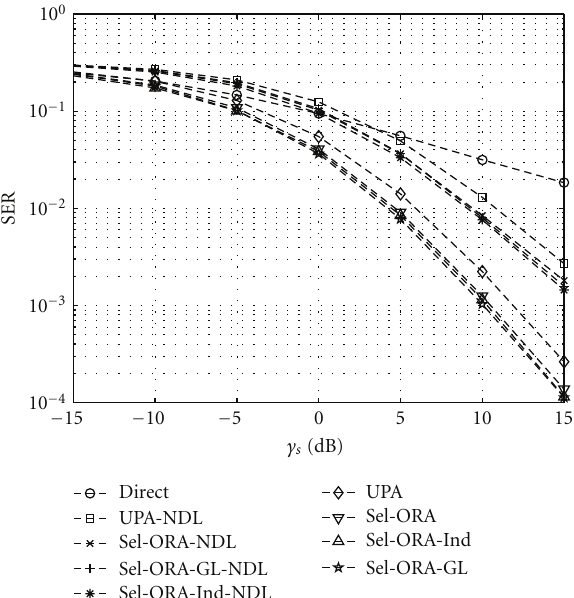
Figure 5: SER as a function of number of layers ( m ) for the AP system. Figure 6: Comparison of SER performance of a selection system under di ff erent schemes and constraints with m = 3.